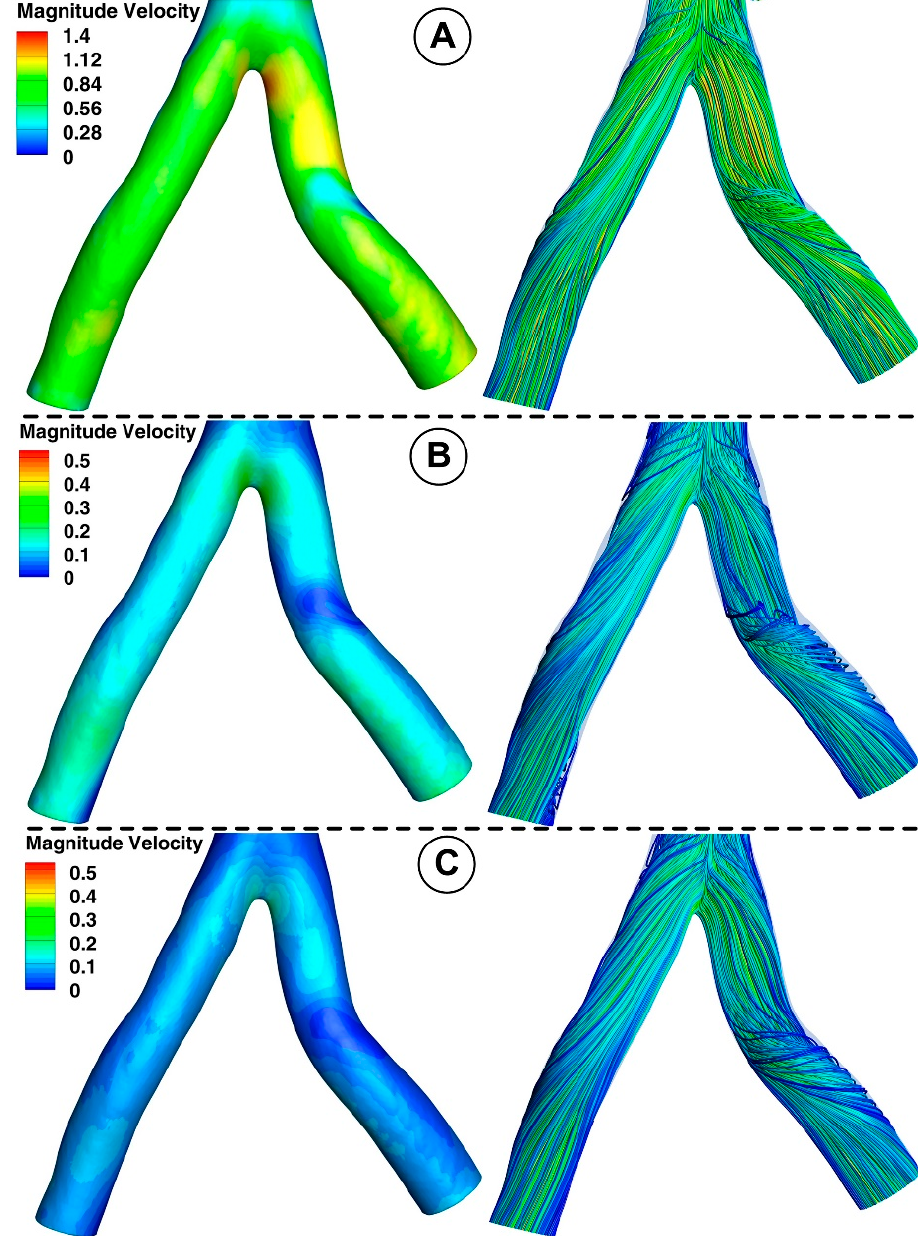
Figure 11. Velocity field distribution ( left ) and the path line ( right ) in the iliac artery bifurcation for different time steps. ( A ) T1 = 0.15 s; ( B ) T2 = 0.45 s; ( C ) T3 = 0.6 s.